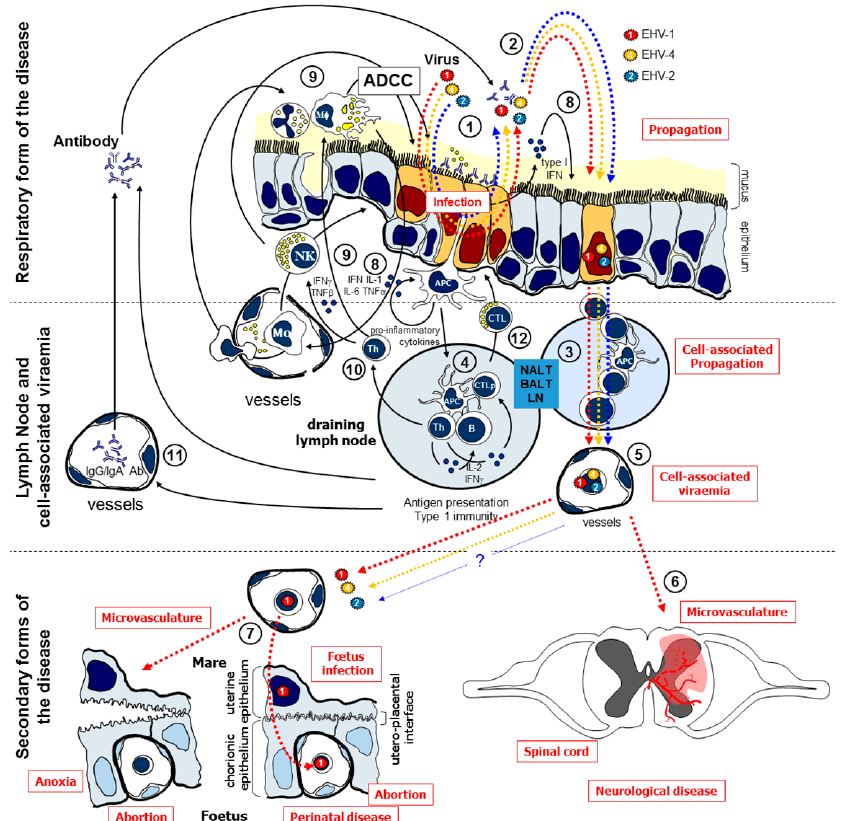
Figure 1. Equine herpes virus (EHV) infection and immune response, adapted from [12]. EHVs primarily infect the epithelial cells of the upper respiratory tract (1), where they replicate and are excreted (2). EHVs will reach the respiratory lymph nodes (3) where peripheral blood mononuclear cells (PBMC) will be infected (4) and the adaptive immune response will be stimulated. Circulation of infected leucocytes (5) during cell-associated viraemia disseminates EHVs to distant sites such as the central nervous system (EHV-1) (6) or the reproductive tract (EHV-1/4; potentially EHV-2). EHV-infected maternal lymphocytes reach the endometrial capillary during the cell-associated viraemia (7). EHV-1 spreads by cell-to-cell contact to the foetus through the endothelium of endometrial capillaries, the uterine epithelium, the chorionic epithelium and the endothelium of placental capillaries to finally infect foetal lymphocytes. EHV-1 can also infect endometrial endothelial cells inducing uterine pathologies, leading to a premature placenta separation and foetus anoxia. EHV-1 could also reach the central nervous system (6), infect, and damage endothelial cells, potentially leading to microvasculature and equine herpesvirus myeloencephalopathy (EHM). Infection with EHVs also induces the establishment of latency and potential reactivation of infectious virus (not represented here). In terms of immune response, the local synthesis of IFN and IL-6 by infected endothelial cells and innate immune cells will promote antiviral resistance in uninfected cells and up-regulation of major histocompatibility complex (MHC) molecules for viral antigen presentation to the immune system (8). Alveolar macrophages (M φ ) and neutrophils respond to the infection by releasing pro-inflammatory cytokines, leading to the containment of the infection, rise of body temperature, and to the recruitment of further phagocytic and natural killer (NK) cells (9). NK cells are activated by IFN- α and interleukin (IL)-12 which is synthesised by M φ , and are cytotoxic for virus-infected cells. NK cells synthesise IFN- γ that drives the development of the adaptive immune response. The presentation of viral antigen (10) in lymphoid tissues induces the synthesis of serum (11) or mucosal antibodies able to neutralise excreted virus and to stimulate antibody dependent cell cytotoxicity (ADCC). Virus-specific cytotoxic T lymphocytes (CTL) that lyse infected cells are also stimulated (12). APC: antigen presenting cell; BALT: bronchus-associated lymphoid tissue; LN: lymph node; NALT: nasal-associated lymphoid